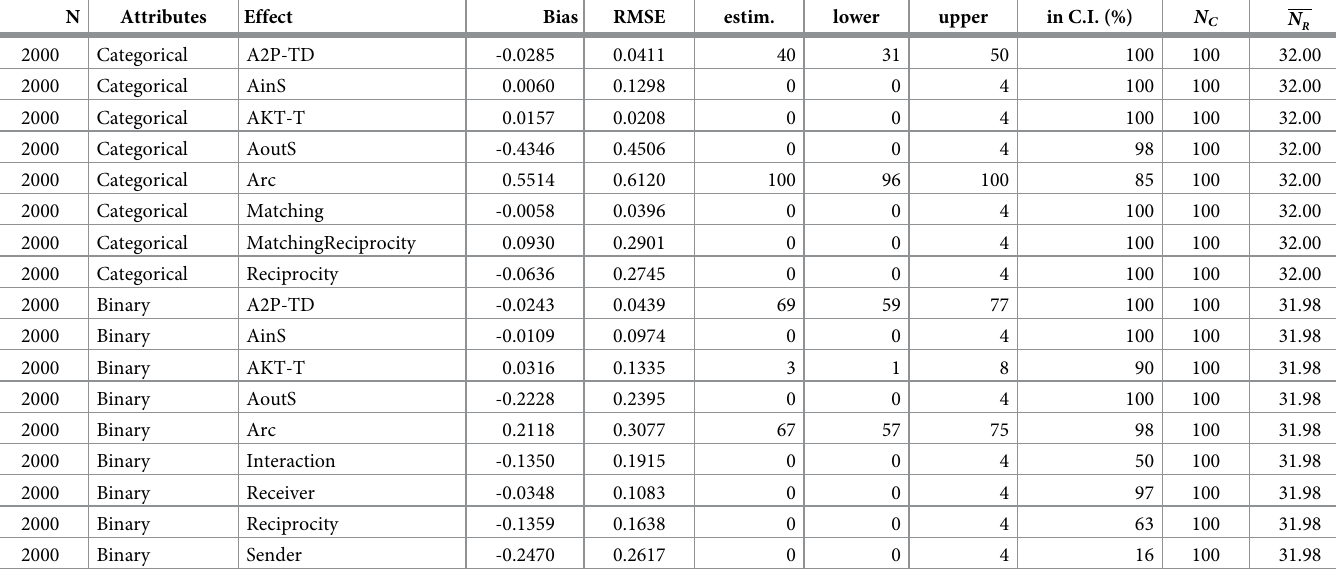
Table 2. Results from estimation of simulated networks using EstimNetDirected estimating Type II error rate.